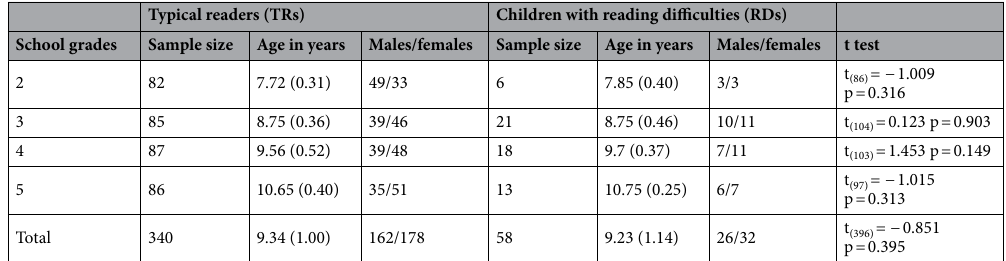
Table 1. Sample size, chronological age (mean and standard deviation) and gender (number of males and females) characteristics of typical readers (TRs) and children with reading difficulties (RDs) in the different school